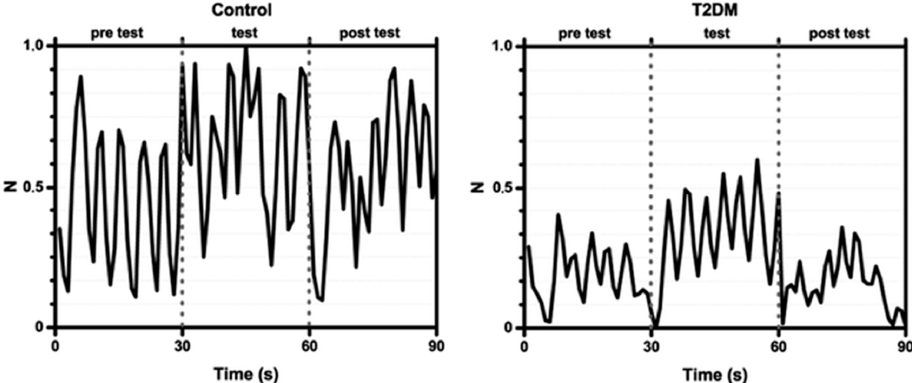
Figure 21. Normalized breath signal in a representative control subject compared with that in a diabetic (T2DM) subject, recorded through the consecutive phases of the experiment; pre-test: signal of normal free breathing, test: breathing signal during cognitive test; post-test: recovery breathing signal after the cognitive test. Normalization formula is X ¼ ( x i − x i, j min )/( x i,j max − x i, j min ). Used with permission from [109].